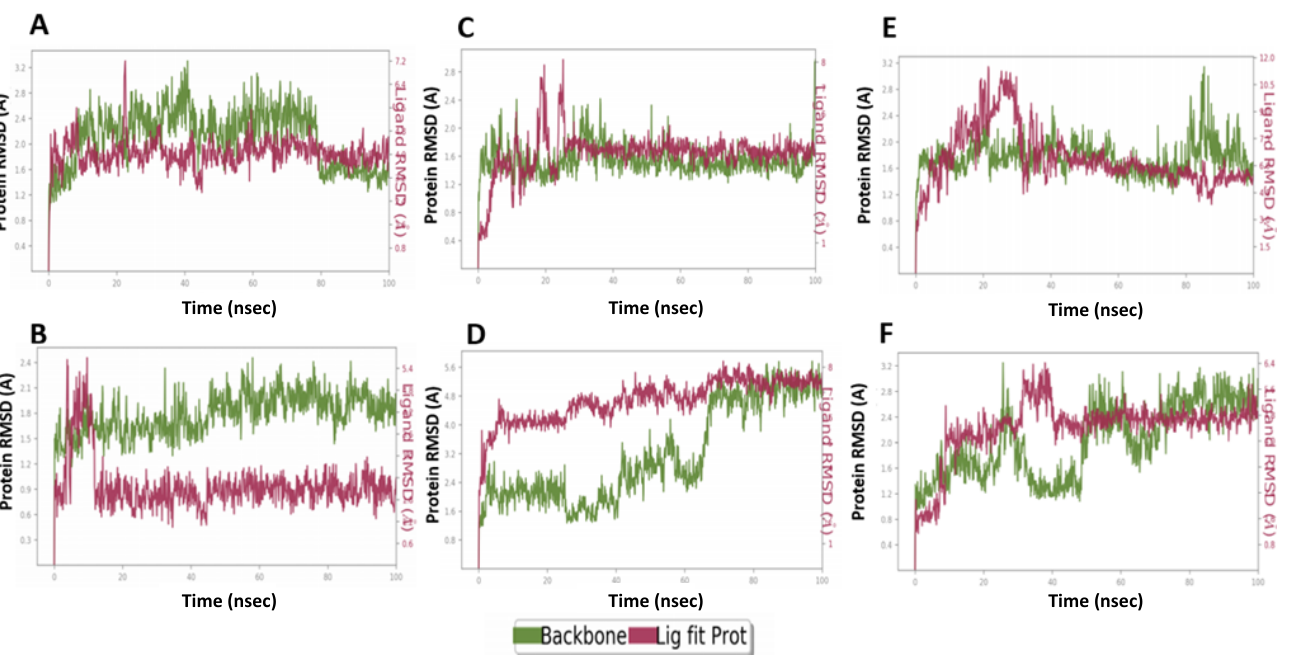
Figure 9 Figure 9. The root mean square deviation (RMSD) plots of compounds M1–5 compared to Compound 13 with SARS-CoV-2